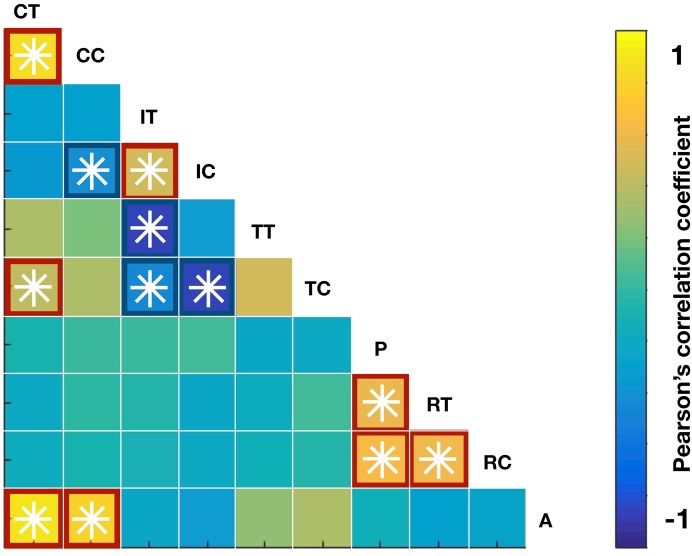
Cross-correlation matrix showing.Pearson’s correlation coefficients (Bonferroni-corrected for multiple comparisons at α = 0.05/10 = 0.005; 10 is the number of tests involving each variable). Abbreviations and variables are listed underneath the matrix.* p<0.005 CT: coordination tone; CC: coordination contour; IT: innovation tone; IC: innovation contour; TT: Transmission tone; TC: transmission contour; P: proximity; RT: regularization tone; RC: regularization contour; A: accuracy.